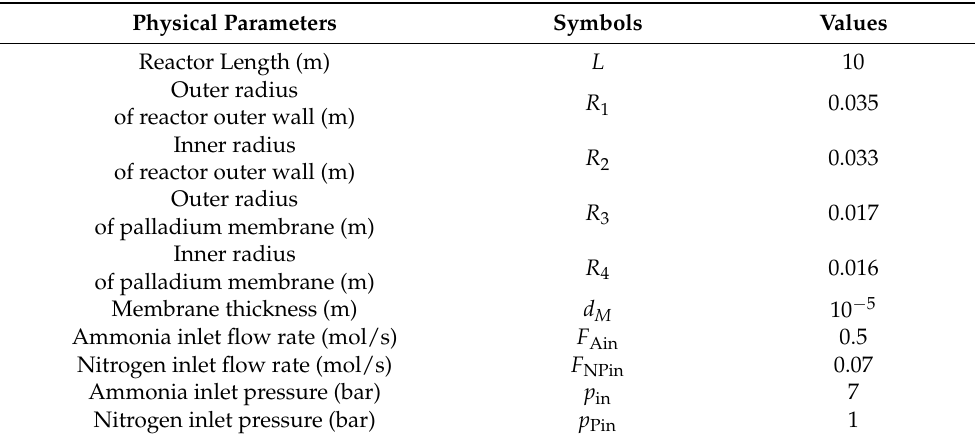
Figure 2. Cutaway view of the ammonia decomposition membrane reactor. ( R 2 is the inner radius of reactor outer wall; R 4 is the inner radius of membrane). The basic parameters of the membrane reactor model are shown in Table 2. Table 2. Basic parameters of the